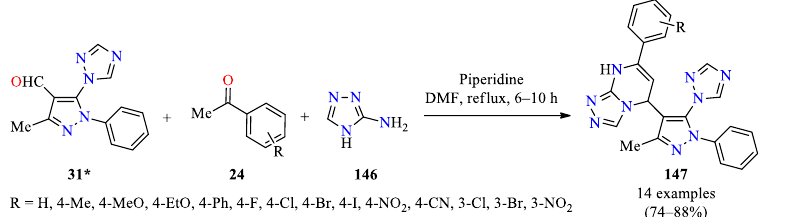
Scheme 24. Three-component synthesis of pyrazole-triazolopyrimidine hybrids 147 as α -glucosidase